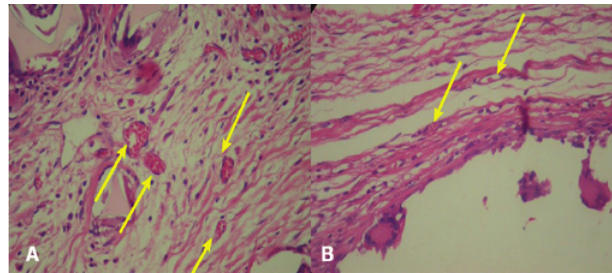
FIGURE 6 – Photomicrographs. A . Polyurethane foam with evidence of marked vascular neoformation. B . Silicone foam with discrete neoformation (200x). Note: In A , arrows indicate vessels and blood into the vessels and in B , small amount of